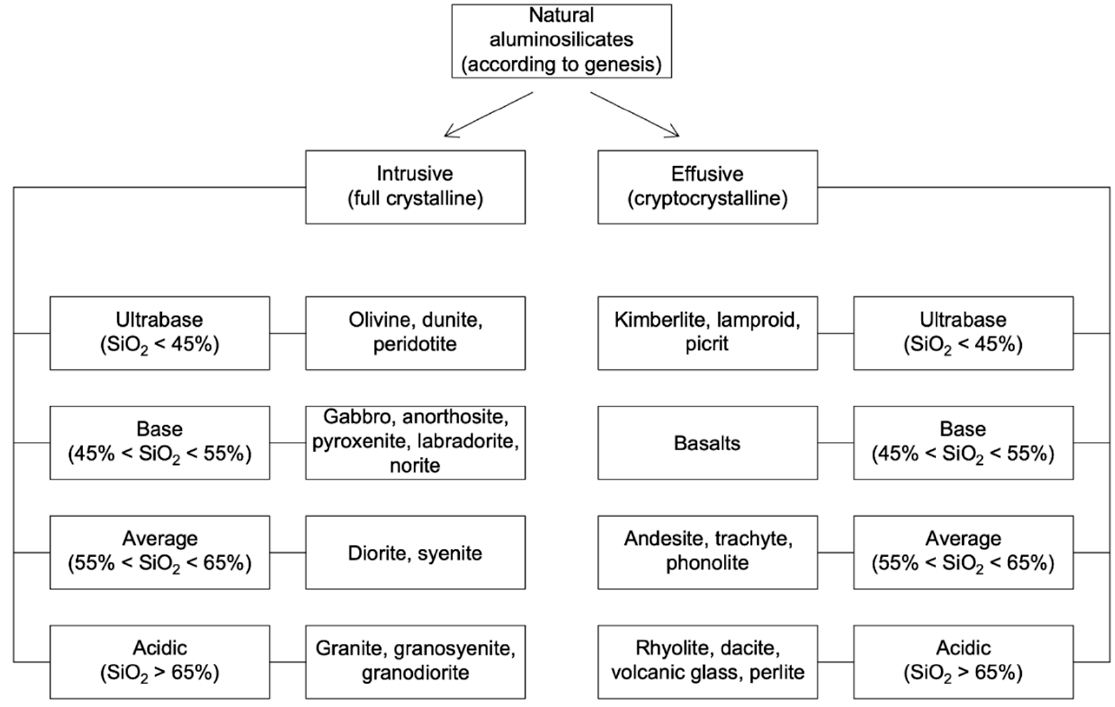
Figure 1. Classification of natural aluminosilicates.